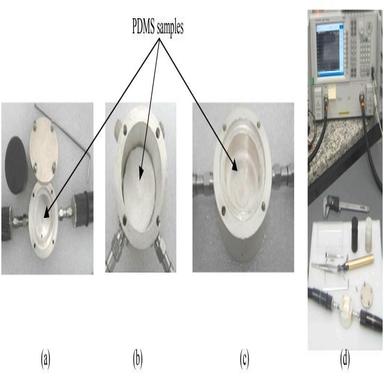
Resonance measurements: (a) PDMS sample diameter fits the resonator R22 diameter; (b), (c) PDMS samples have a smaller diameter in resonators R11 and R21; (d) measurement scheme by VNA in the frequency range 0.01–40 GHz.